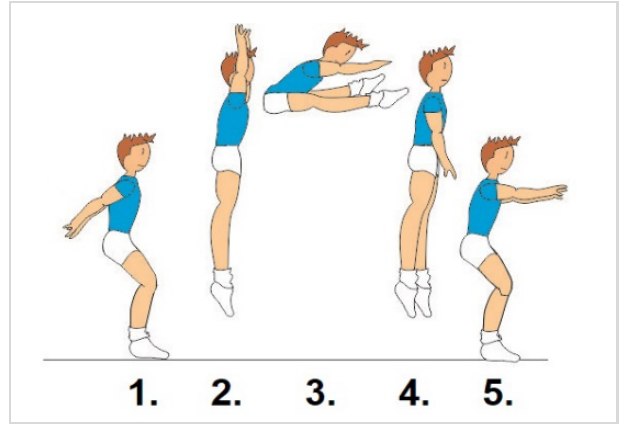
Figure 1. Straddle jump: 1. approach; 2. take off; 3. culmination; 4. descent; 5. landing. In intervention program 2 (IP2) gymnasts practiced a split jump (Figure 2) using expert modeling followed by verbal feedback. At the beginning of each TS, the gymnasts were presented with a video of the expert model. Subsequently, they performed the selected element in two series of three repetitions, while each attempt was followed by individual verbal FB by the coach. After each series, the gymnasts were again provided with a video of the expert model. After completing the second series and watching the video, they made another attempt with an effort to make it without mistakes. All videos were always presented once at standard speed and once in slow motion, while the coach always pointed out key factors of the